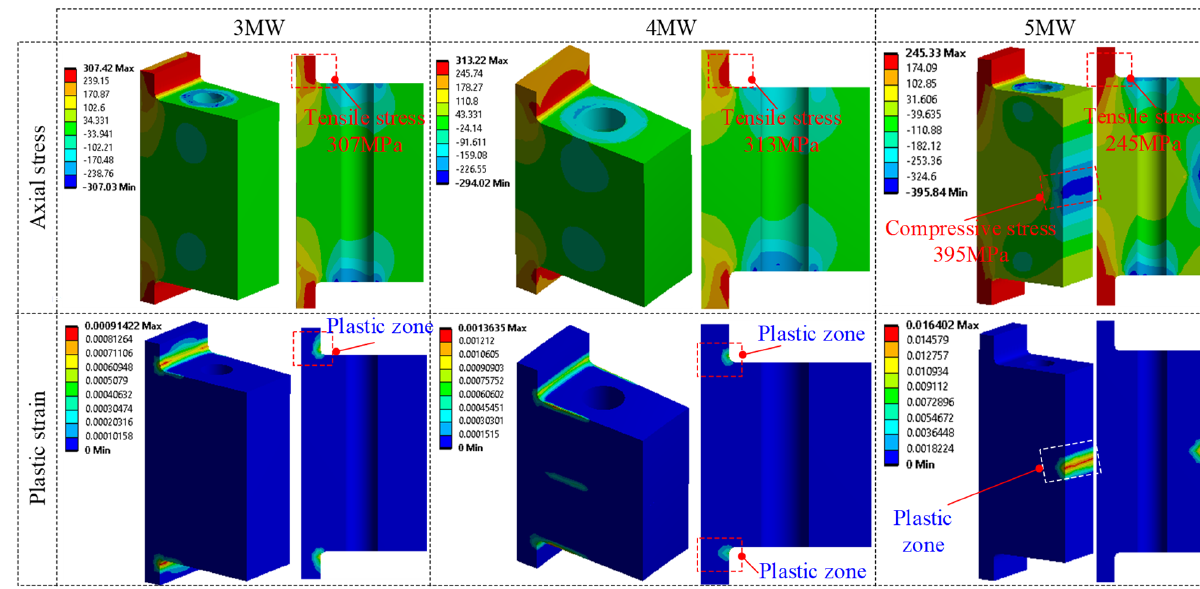
Figure 5. Axial stress and plastic strain in the flange member.